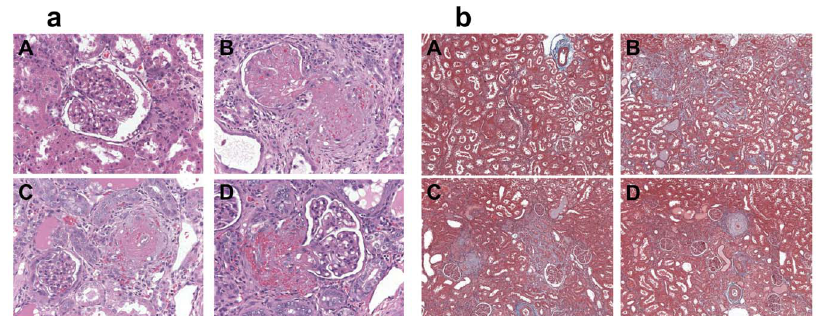
Figure 3. Assessing renal morphology and fibrosis. a: H&E staining to assess the renal morphology of Dahl rats following: LS-diet with nearly normal morphology (A) or HS-diet and administration of vehicle, showing fibrinoid arteriolar necrosis with extravasation of erythrocytes and thrombosis of glomerular capillaries (B); INT-747 at 10 mg/kg/day shows similar findings (C) as does INT-747 at 30 mg/kg/day (D) for 6 weeks. Representative images are shown. (400X mag). b: Masson’s Trichrome staining to evaluate renal fibrosis (seen as blue-colored expansion of the interstitium between the tubules) in Dahl rat kidneys following: LS-diet (A) or HS-diet and administration of vehicle (B); INT-747 at 10 mg/kg/day (C) or INT-747 at 30 mg/kg/day (D) for 6 weeks. Representative images are shown. (100X mag).